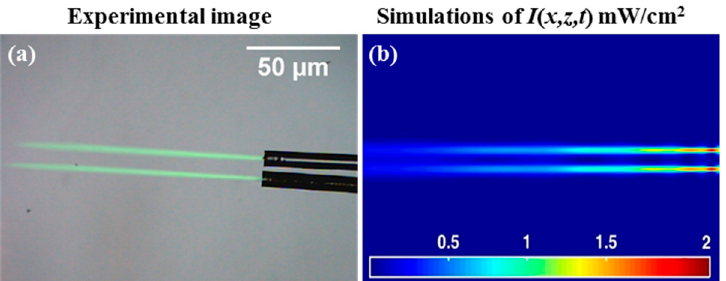
Figure 5. ( a ) Experimental observations (from right to left) for the SWW formed by exposure, t exp = 1600 s of λ = 532 nm and P 0 = 0.1 mW (i.e., each fiber has P 0 = 0.1 mW); two parallel single mode fiber optical cables; ( b ) simulated light intensity distributions, I ( x,z,t ) mW/cm 2 .